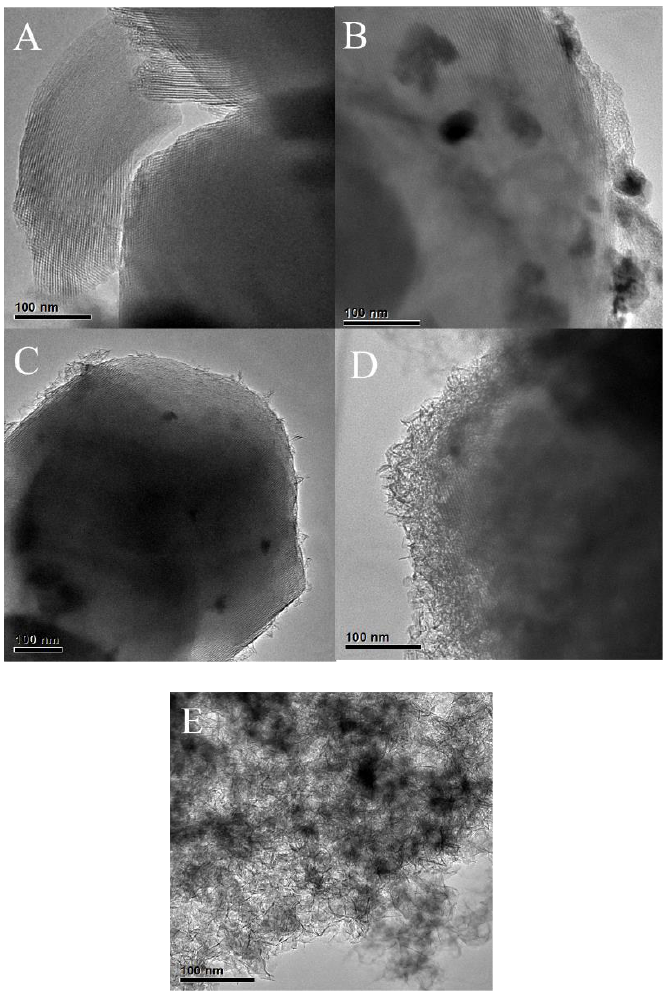
Figure 3. The TEM images of MCM-41( A ), reduced 10% Ni/MCM-41( B ), reduced 5% Ni-MCM-41( C ), reduced 10% Ni-MCM-41( D ), and reduced 15% Ni-MCM-41( E ).